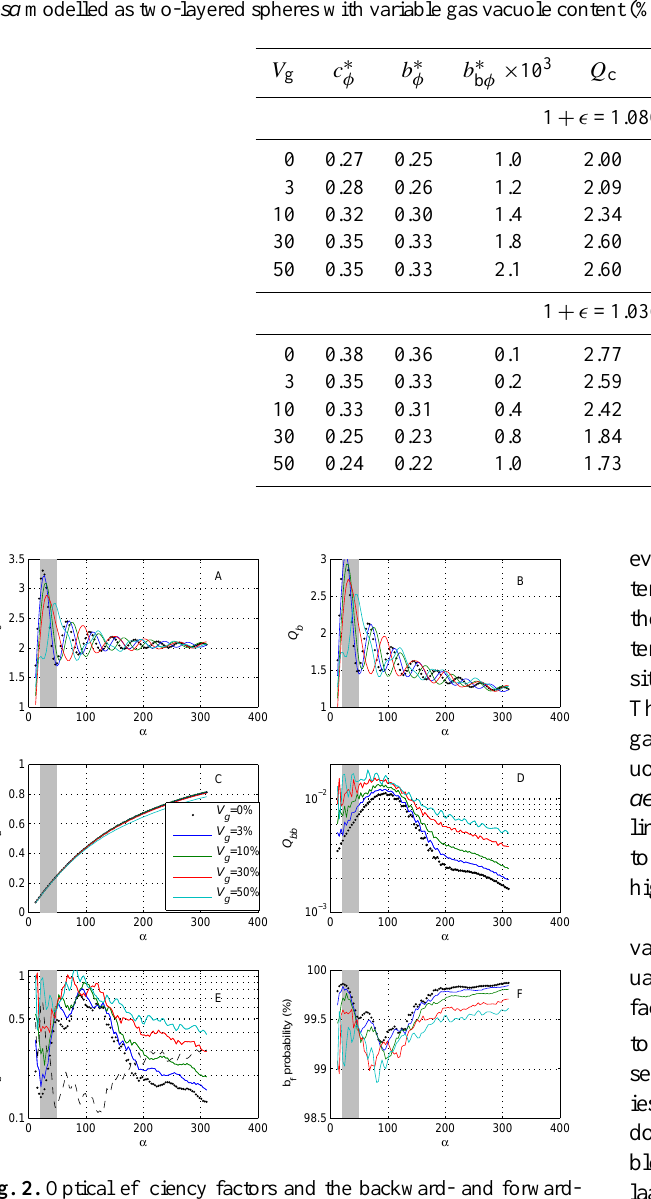
Fig. 2. Optical efficiency factors and the backward- and forward- scattering ratios of M. aeruginosa versus the Mie size parameter, α , modelled as two-layered spheres with variable gas vacuolation (0–50% cell volume). Plotted for cell diameters from 1 to 50µm at λ =675nm. The shading indicates the size range applicable to M. aeruginosa . The dotted line in (E) is the ratio of backscattering probability where V g = 50% to that where V g = 0% × 10 − 1